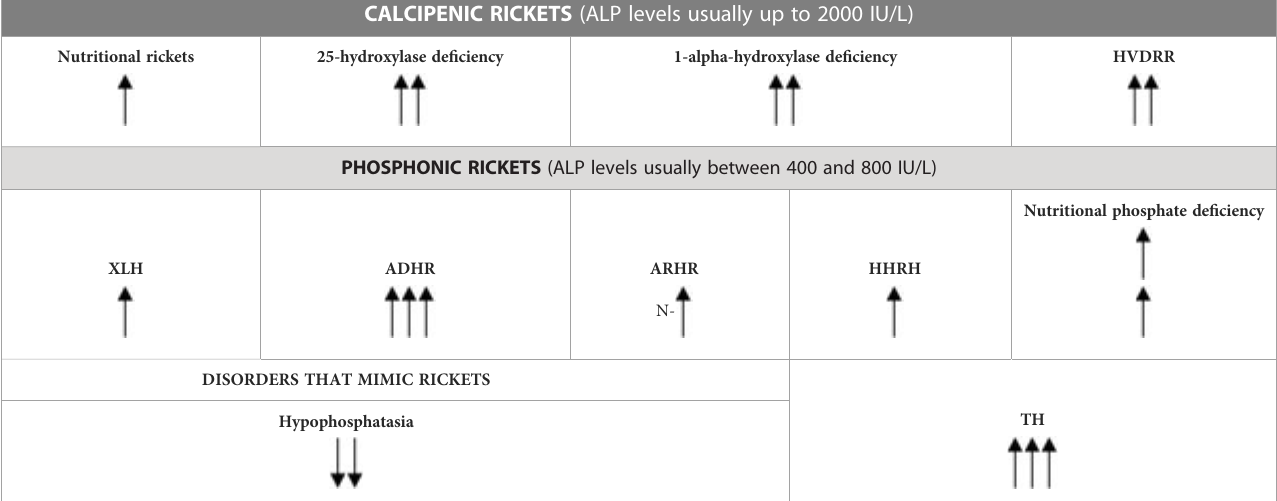
TABLE 1 ALP values in different forms of rickets and in disorders that mimic rickets. CALCIPENIC RICKETS (ALP levels usually up to 2000 IU/L) Nutritional